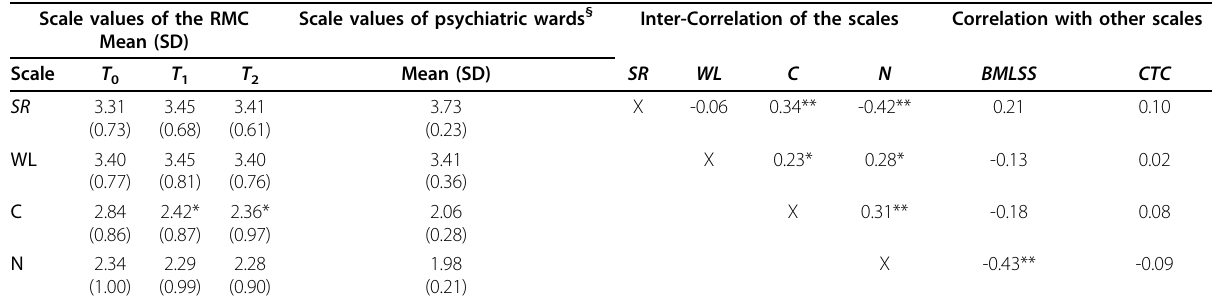
Table 2 Mean values and Interrelationship between the WES-10 subscales given by Spearmans ’ s correlation coefficients